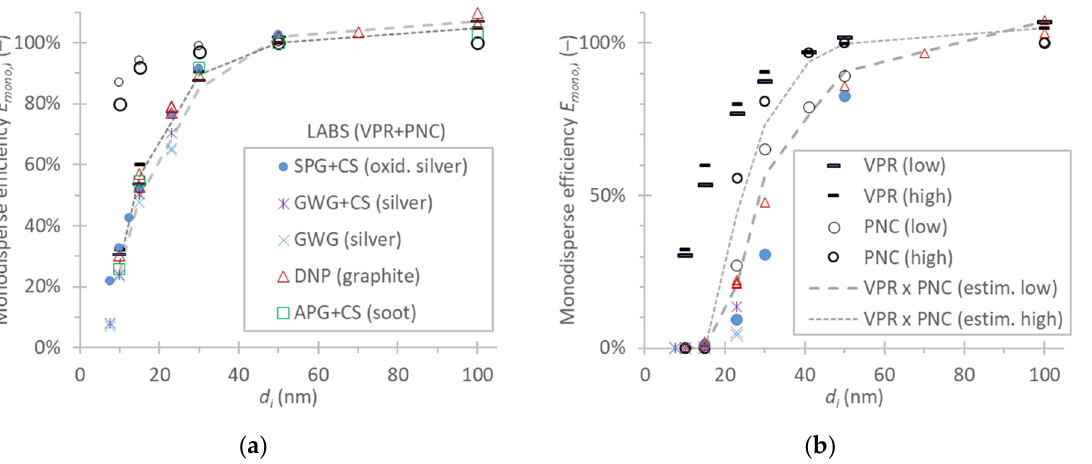
Figure 7. Comparison of monodisperse calibration in parts (VPR or PNC) or as a complete system (LABS = VPR + PNC): ( a ) 10 nm; ( b ) 23 nm. The PCRF of the LABS was 100. Note that the legend is split in the two panels.